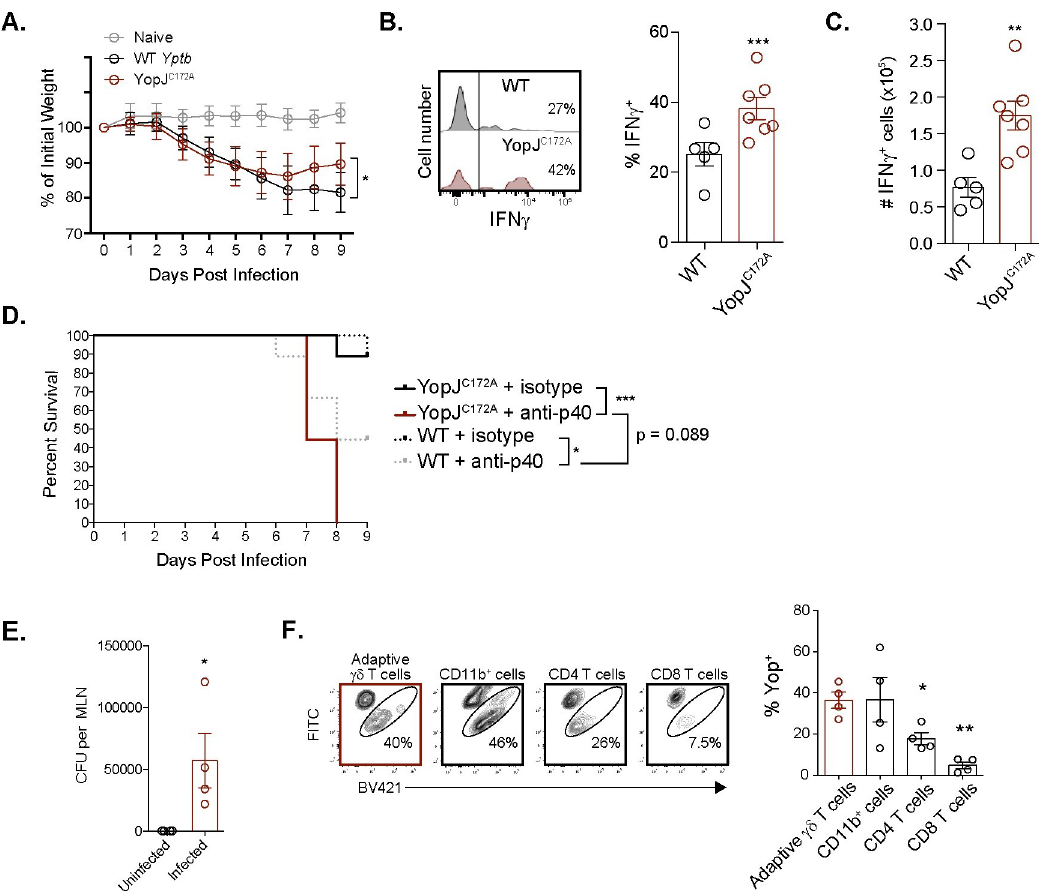
Fig 6. Foodborne YopJ C172A Y . pseudotuberculosis infection elicits an IFN γ response from V γ 4 T cells. ( A - E ) Balb/c mice were foodborne infected with WT (2-4x10 7 CFU) or YopJ C172A Y . pseudotuberculosis (2-4x10 8 CFU). ( A ) Mouse weight was assessed daily after infection. ( B and C ) Nine days post infection, MLN were processed into single cell suspensions and stimulated with PMA/ionomycin in the presence of brefeldin A for 4 hours. V γ 1.1/2 - CD44 hi CD27 - γδ T cells were analyzed for IFN γ production. Representative histograms are displayed. Graphs represent mean ± SEM and are pooled from 3 experiments with a total of 5–8 mice per group. ( D ) Mouse survival was assessed daily after infection. anti-IL-12p40 antibody was administered at 0.2 mg/mouse on 0, 2, 4, and 6 days post infection. A Kaplan-Meier survival plot is shown. Study endpoint was 9 days post infection. The data represent 2 independent experiments with a total of 9 mice per group. ( E and F ) Balb/c mice were foodborne infected with 2x10 9 CFU L . monocytogenes to elicit a V γ 1.1/2 - CD44 hi CD27 - γδ T cell population in vivo . 30 days post infection, immunized mice were foodborne infected with WT Yptb - β la (2-4x10 9 CFU) or left uninfected. ( E ) CFU of WT Yptb - β la were enumerated in MLN 3 days post WT Yptb - β la infection. ( F ) Three days post foodborne WT Yptb - β la infection, V γ 1.1/2 - CD44 hi CD27 - γδ T cells from the MLN were analyzed for Yop translocation using the CCF4-AM assay. Representative contour plots are shown. Yop translocation (Yop + ) among the indicated populations is depicted as mean ± SEM and is pooled from 2 experiments with a total of 4 mice per group. ��� p < 0.001, �� p < 0.01, and � p < 0.05. A repeated measures one-way ANOVA was used for ( A and F ) and an unpaired t- test was used for ( B , C , and E ). Experimental groups were compared to WT Y . pseudotuberculosis in ( A - C ),uninfected controls in ( E ), and V γ 1.1/2 - CD44 hi CD27 - γδ T cells in ( F ). A logrank test was used for survival curves in ( D